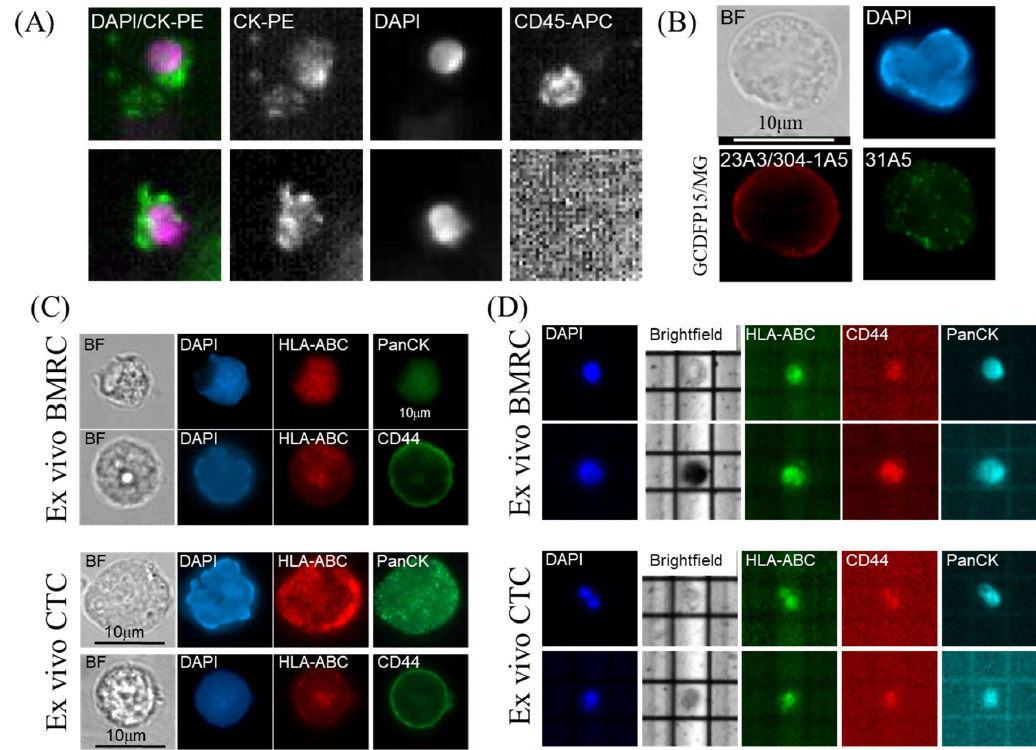
Figure 4. Validation of ex vivo BMRC/CTC using complementary imaging platforms. ( A ) Detection of ex vivo human CTCs by CellSearch CTC (epithelial) kit. The kit enumerates CTCs using DAPI, Pan-cytokeratin-PE (CK-PE), and CD45-APC staining. Upper panel shows a CTC clustering with a CD45+ cell (lymphocyte); lower panels show an individual CTC. Image resolution achieved in accordance with the USFDA-approved CellSearch platform. ( B ) Immunofluorescent (IF) staining of ex vivo BMRC using GCDFP15/MG cocktail. Image of a BMRC showing red IF staining against mouse primary antibody clones 23A3 (GCDFP-15) and 304-1A5 (MG), and green IF staining for rabbit clone 31A5 (MG). ( C ) IF images of single ex vivo epithelial and stem-like BMRCs and CTCs. ( D ) DEPArray